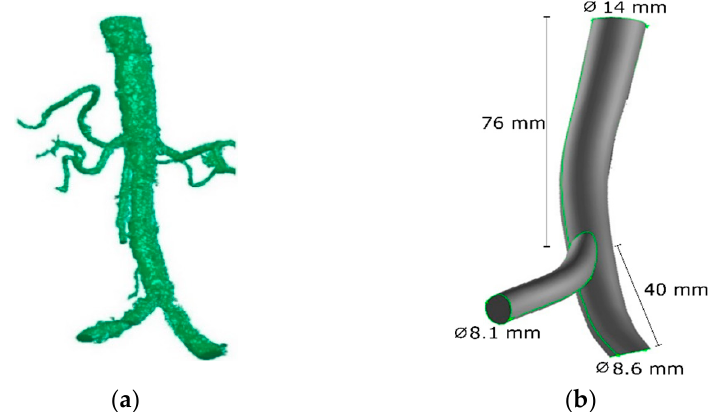
Figure 4. Three-dimensional view of imaging rendering ( a ) and real iliac bifurcation model geometry ( b ).